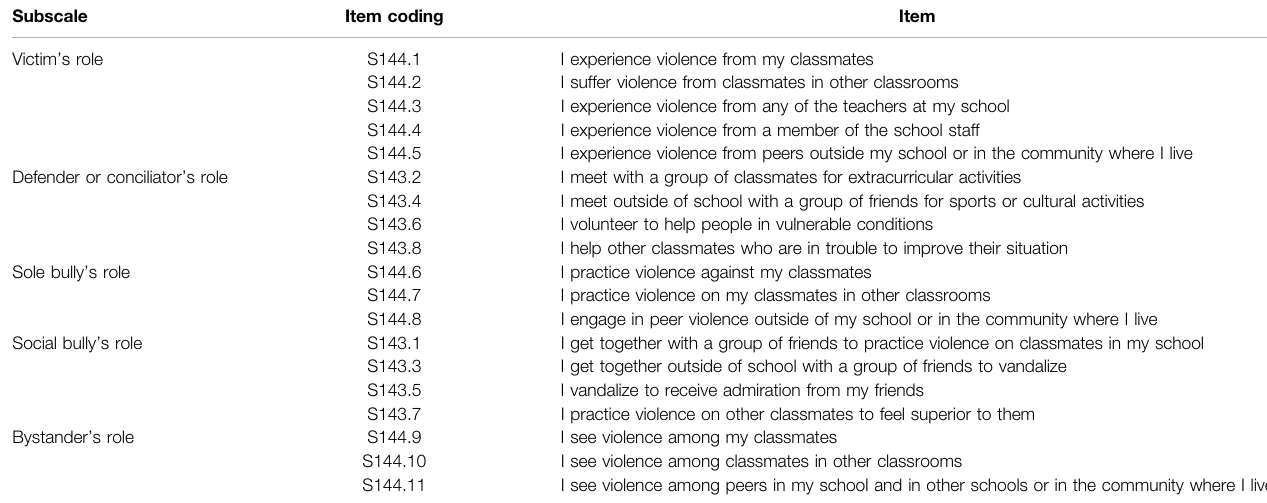
TABLE 1 | Subscales and items of the Scale of the Role of Students in the Cycle of School Violence (ERECVE). Subscale Item